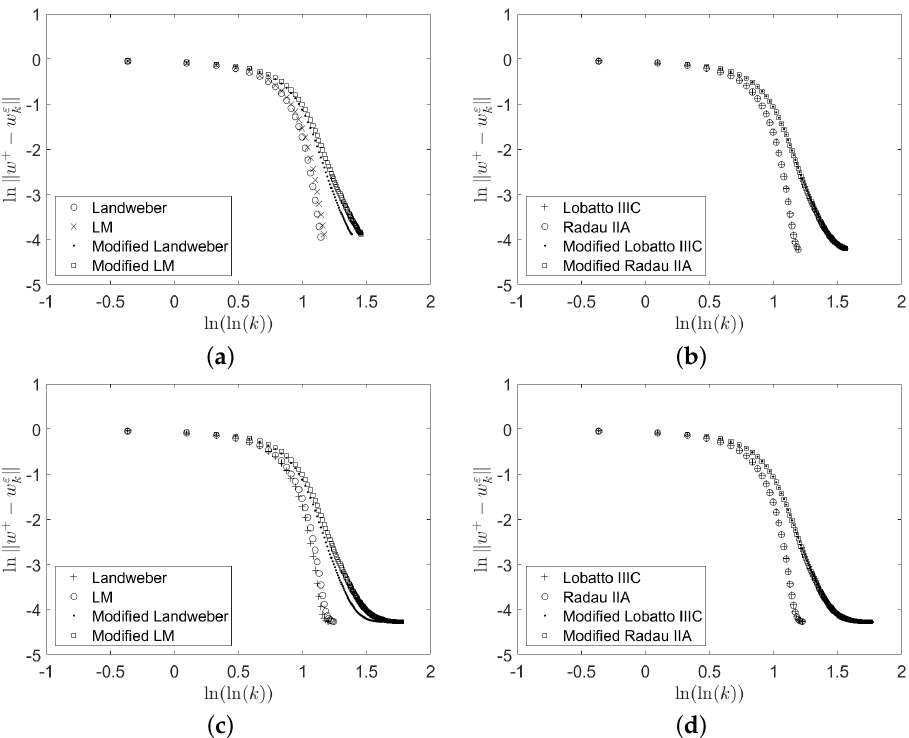
(cid:107) versus ln ( ln ( k )) for ( a ) one − step RK methods and ( b ) for Figure 2. The plot of ln (cid:107) w + − w ε k two − step methods with ε = 10 − 3 . ( c , d ) Results with ε = 10 − 4 . The parameters γ are ( a ) 1.1, ( b ) 25, ( c ) 1.1, and ( d ) 100. For ( a – d ), a harmonic sequence τ k = ( k + 1 ) 1.1 and w 0 = ε w ∗ are